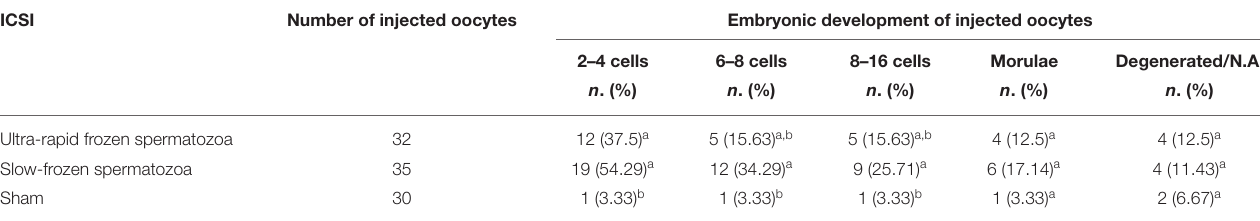
2–4 cells 6–8 cells 8–16 cells Morulae Degenerated/N.A. n . (%) n . (%)